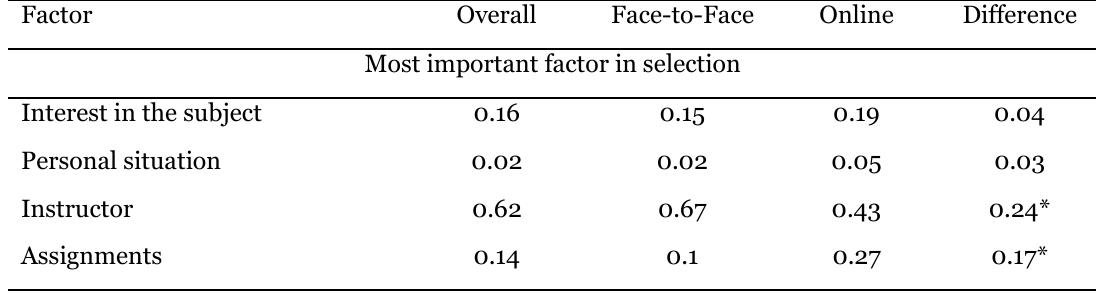
Difference of Means Tests Comparing Best Face-to-Face and Online Classes: Main Factor Influencing Selection